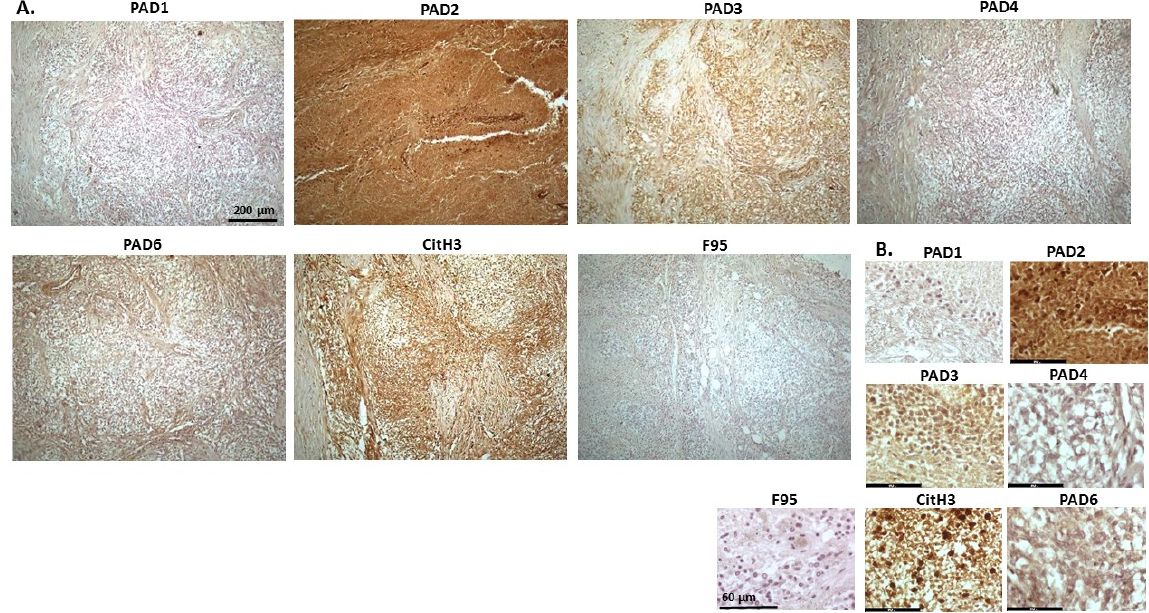
Figure 6. Mink, malignant renal tumour (possibly nephroblastoma). Cadaver, adult mink, male. Tumour in kidney with metastasis to lung and liver. ( A ) Overview images for PAD1, 2, 3, 4, 6, CitH3, and F95 stainings of serial tissue sections; scale bar represents 200 μ m for all images; 10× objective. ( B ) Higher magnification shown for each staining from the images in ( A ); scale bar represents 60 µ m for all images; 40× objective.